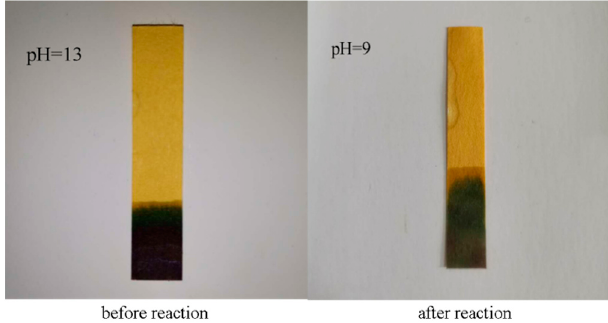
Figure 13. The pH of solution before and after reaction.